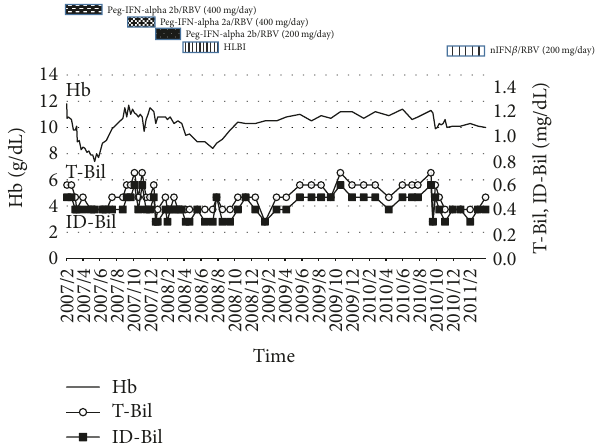
Figure 1: Clinical course of patient (Hb, T-Bil, and ID-Bil). T-Bil: total bilirubin; ID-Bil: indirect bilirubin.